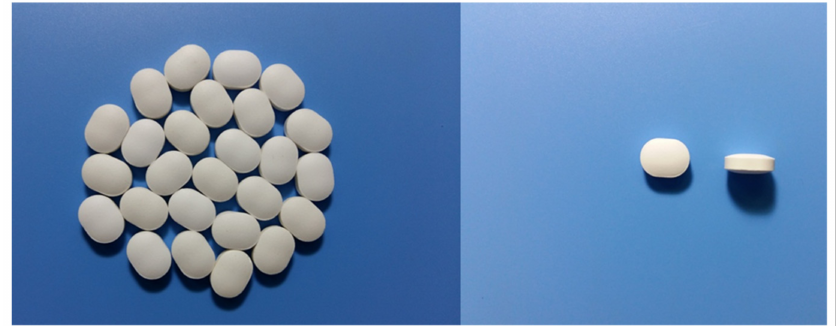
Figure 2. The appearance of the as-prepared film coated bilayer